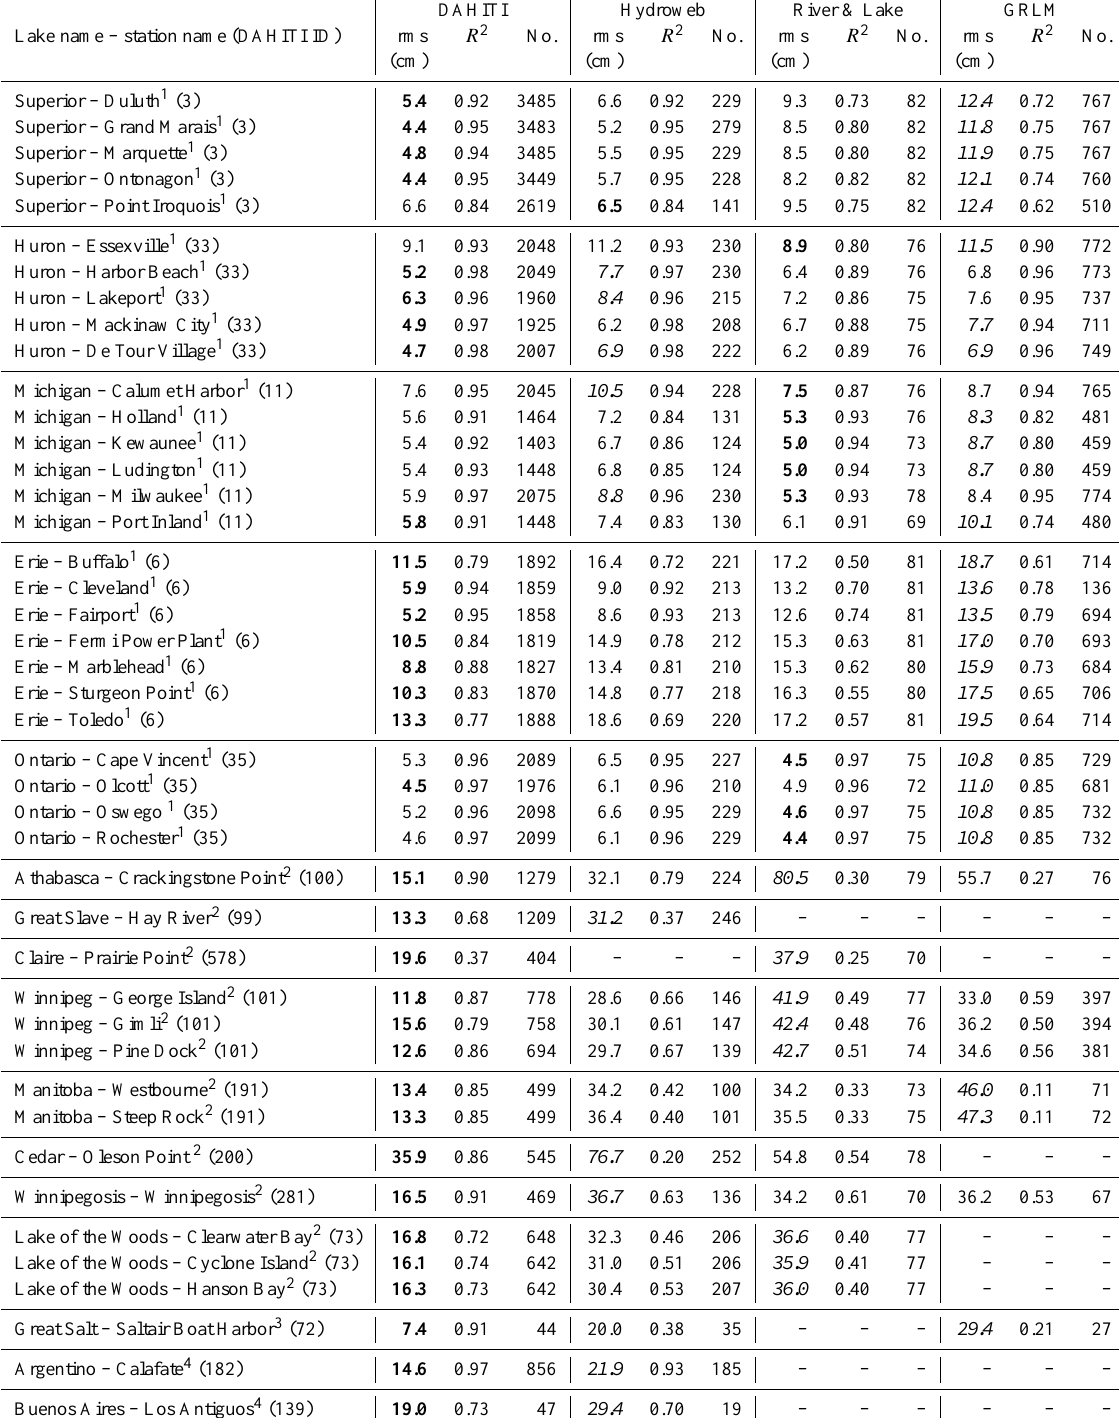
Table 4. Water level time series of selected lakes and reservoirs from DAHITI, Hydroweb, River & Lake, and GRLM compared with in situ data. For each comparison of water level time series from altimetry with in situ data an rms difference and squared correlation is computed. The number of points from the final water level time series which were used for the validation is given in the third column (No.) of each altimeter data set. The smallest rms difference for each target is highlighted in bold, the largest one in